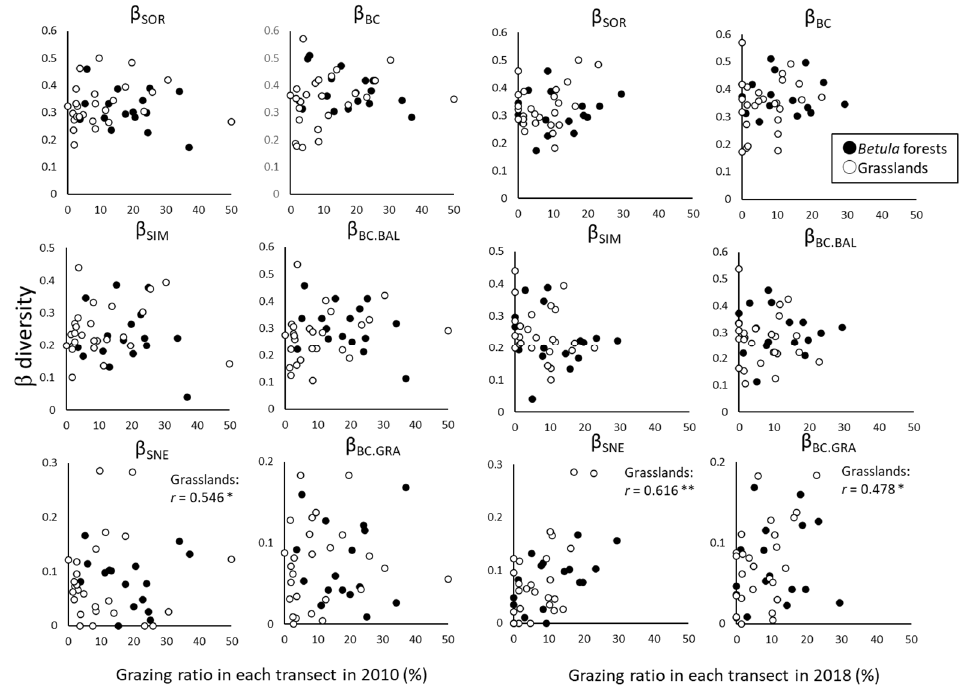
Figure 6. Relationships between grazing ratio (%) in transects and β -diversity in 2010 and 2018 in each transect. Simple correlation was tested by Pearson’s product-moment correlation. * p < 0.05; ** p <